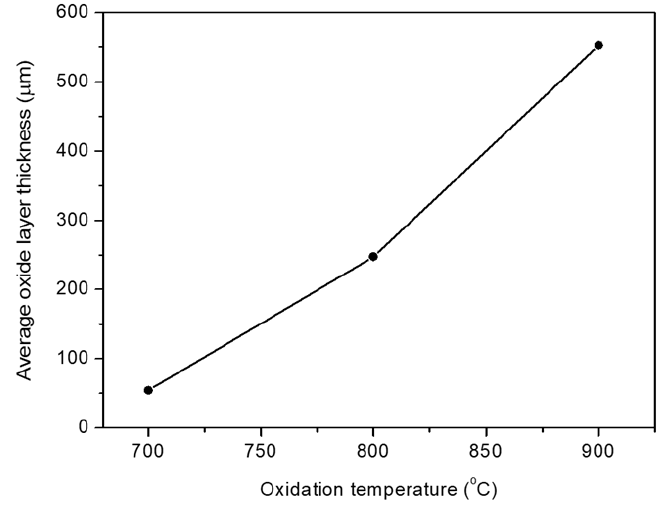
Figure 6. Average oxide layer thickness as a function of oxidation temperature.